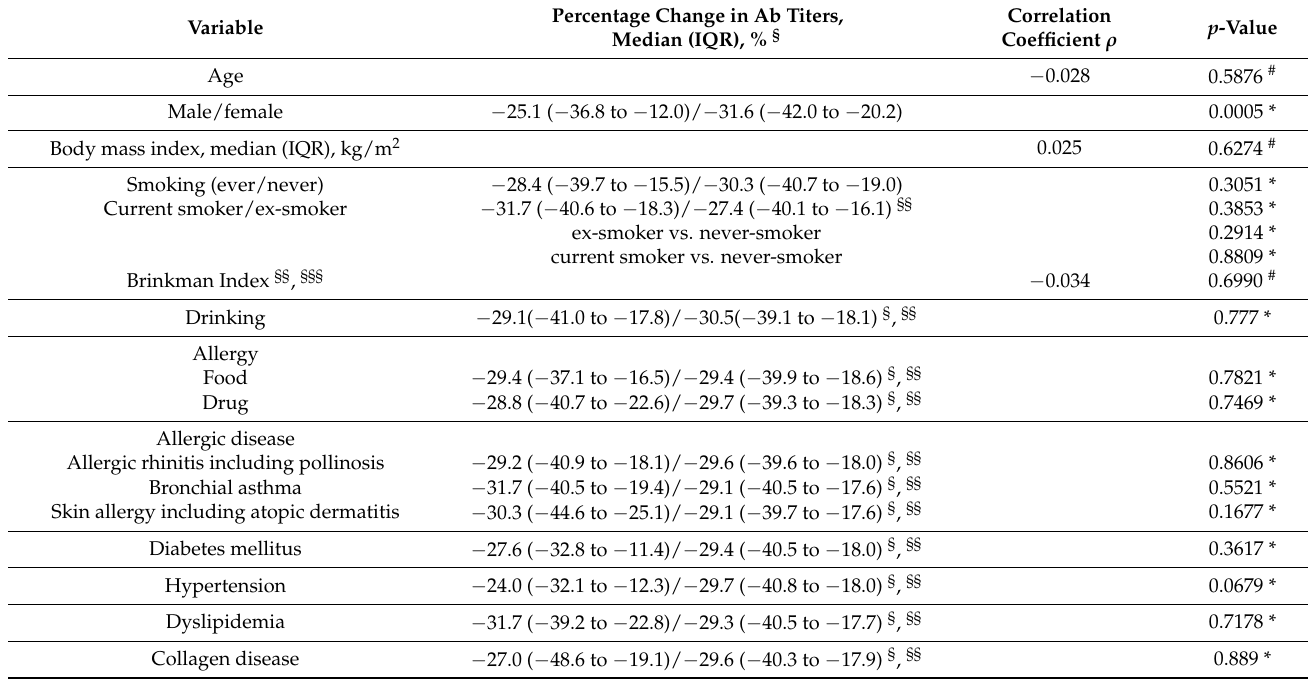
Table 3. Median percentage change in Ab titers from 3 months to 6 months ( N =